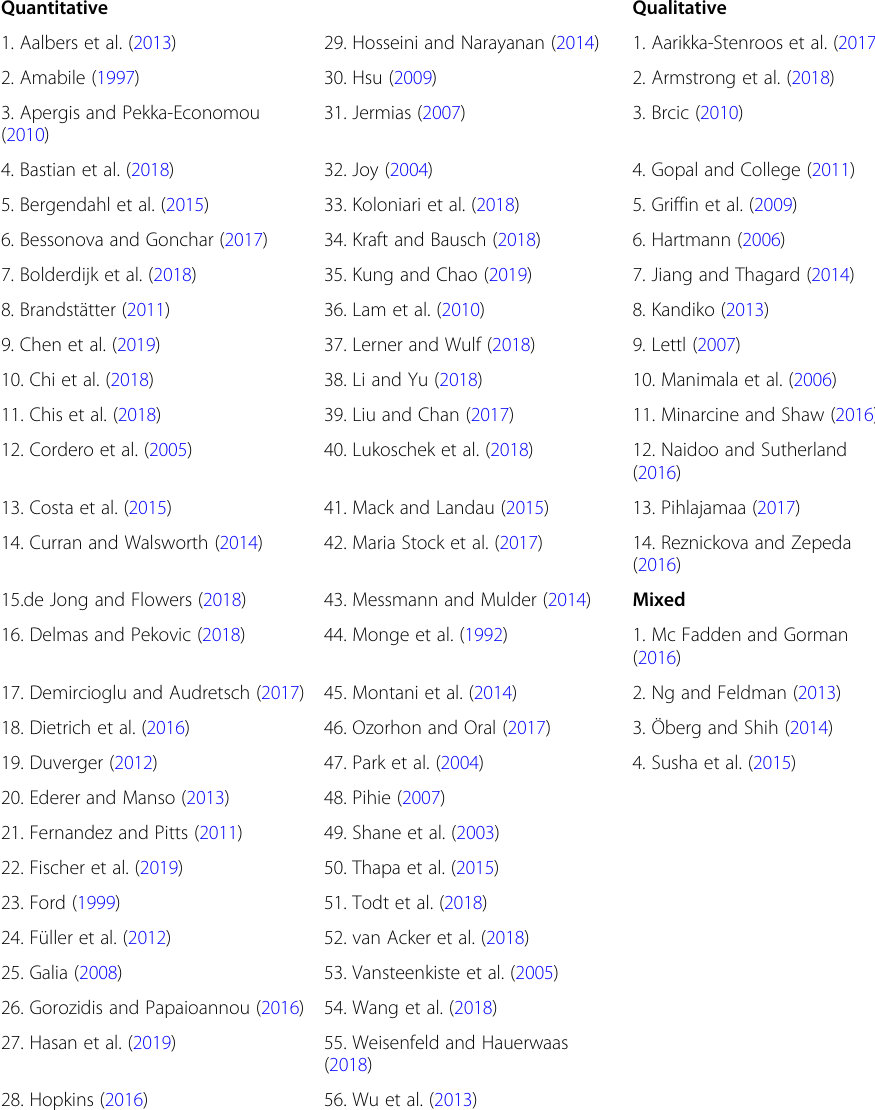
Table 4 Methodology type groupings of included studies Quantitative